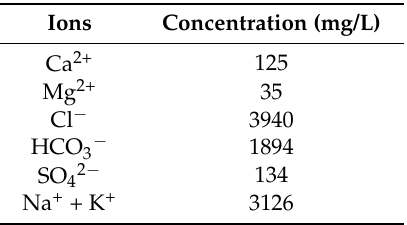
Table 1. The ionic compositions of corrosive solution.